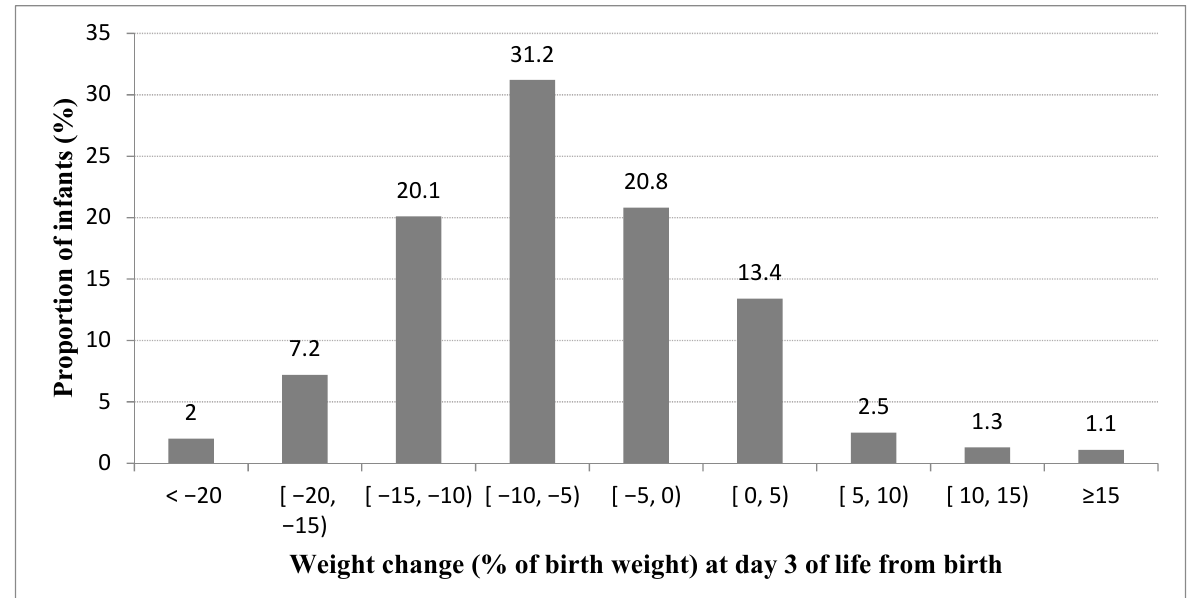
Figure 1. Flow chart of study population.